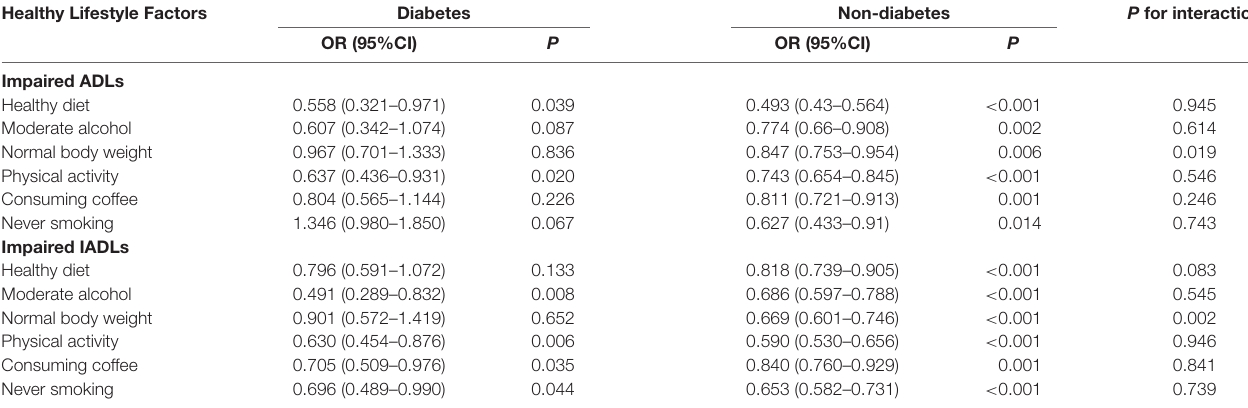
TABLE 3 | Multivariable logistic regression model for the association of healthy lifestyle factors with impaired activities of daily living (ADLs) and instrumental ADLs (IADLs) for individuals with and without diabetes. Healthy Lifestyle Factors Diabetes Non-diabetes P for interaction OR (95%CI) P OR (95%CI)